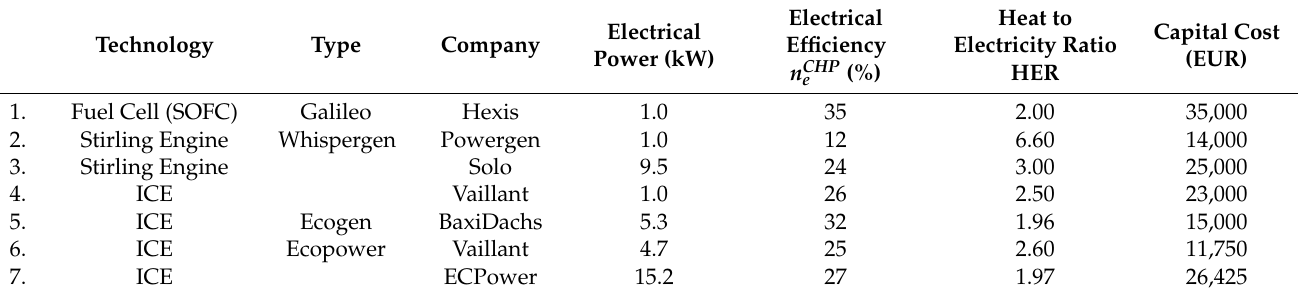
Table 4. Capacity, cost, and technical characteristics of the CHP units.